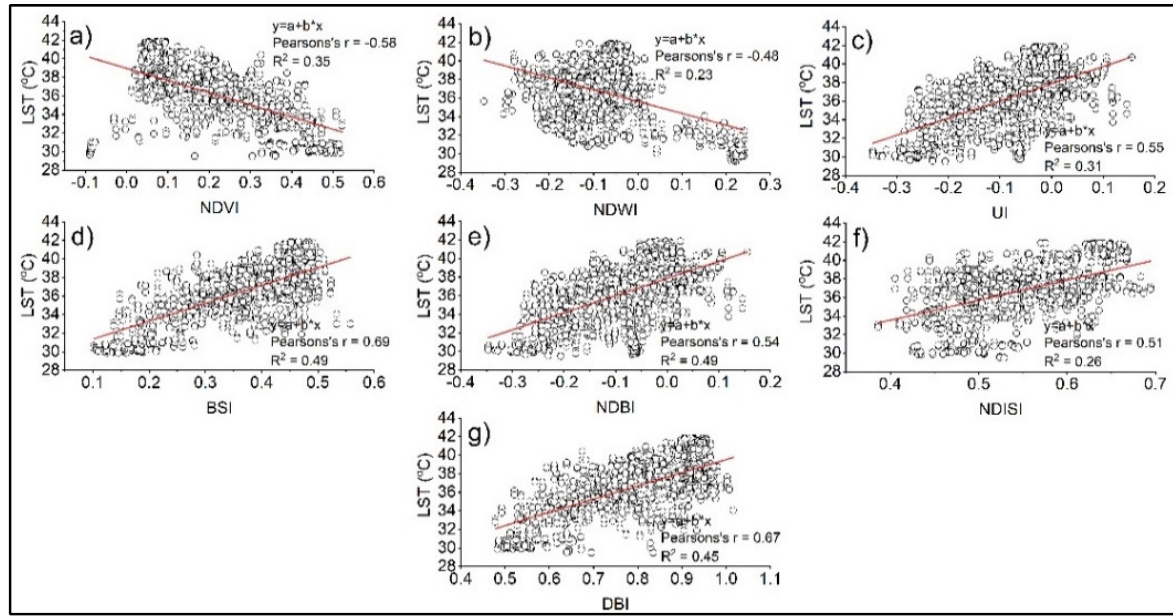
Figure 4. Relationship between LST and LULC indices in transect I, ( a ) NDVI, ( b ) NDWI, ( c ) UI, ( d ) BSI, ( e ) NDBI, ( f ) NDISI, ( g ) DBI.